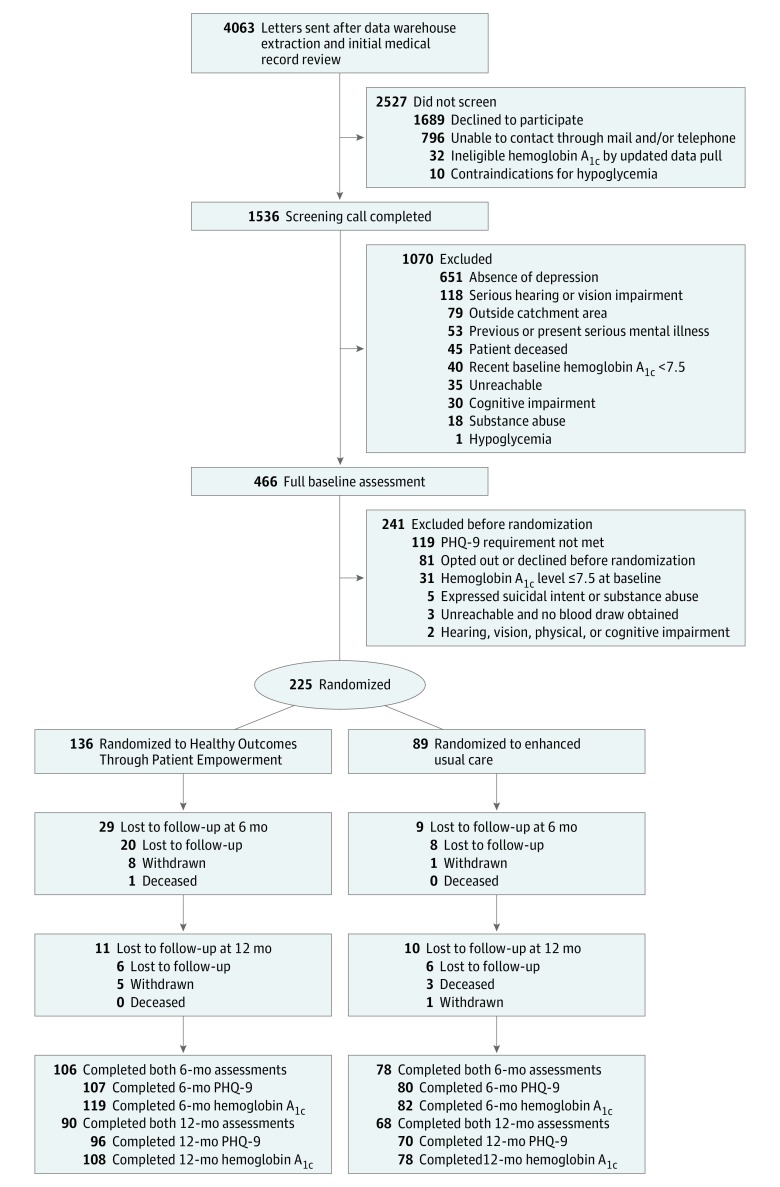
CONSORT Diagram of Patient FlowPHQ-9 indicates Patient Health Questionnaire–9.